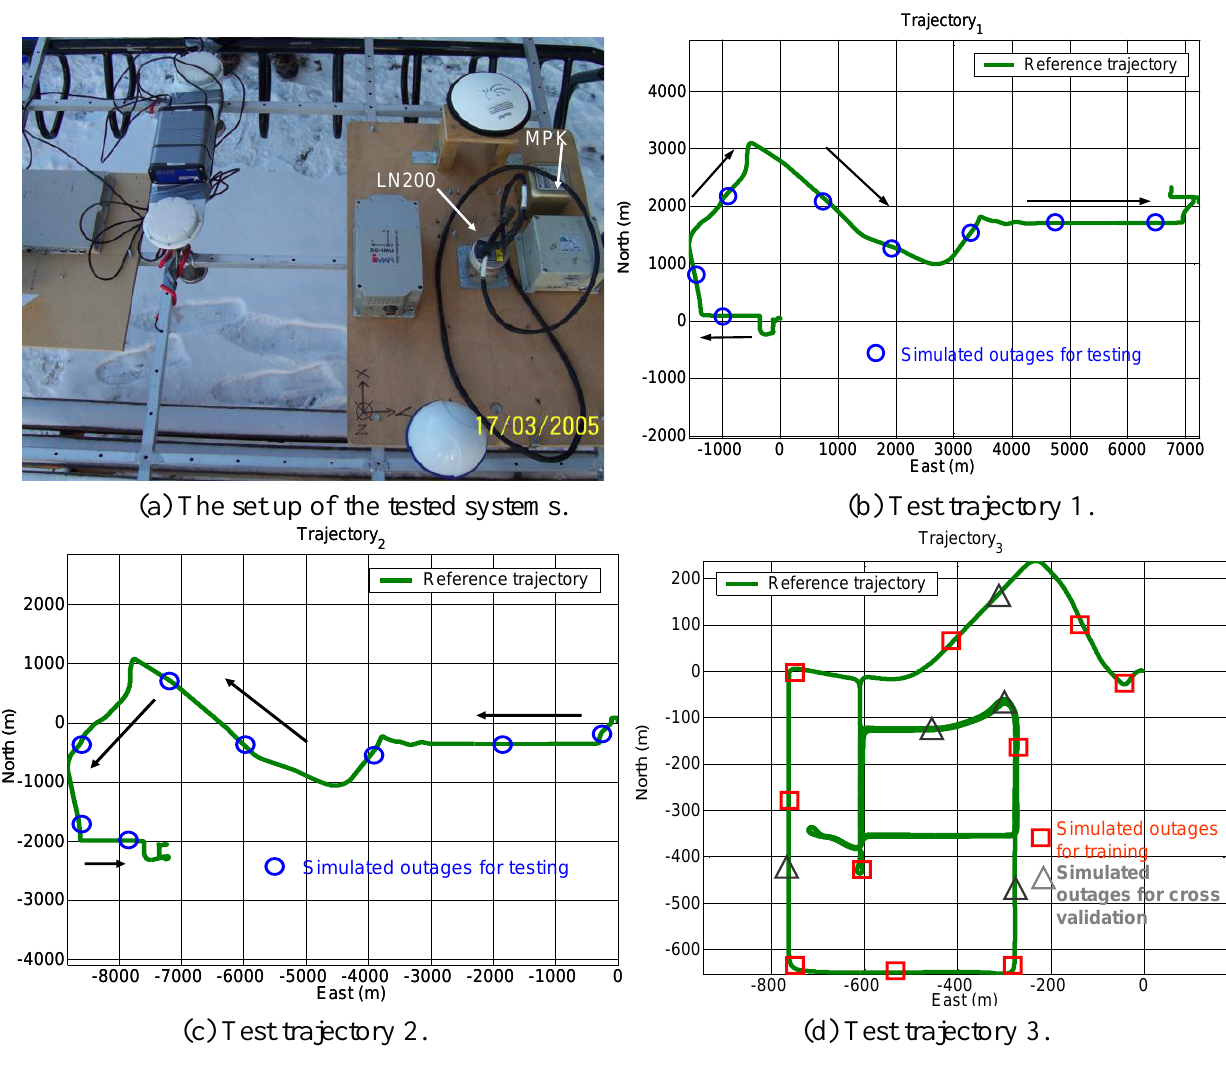
Figure 17. The tested systems and experimental